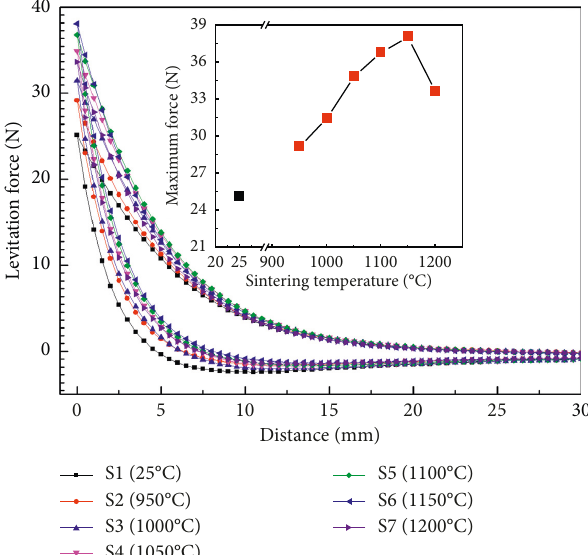
Figure 5: The levitation force of the GdBCO samples prepared with the PSPP sintered at different